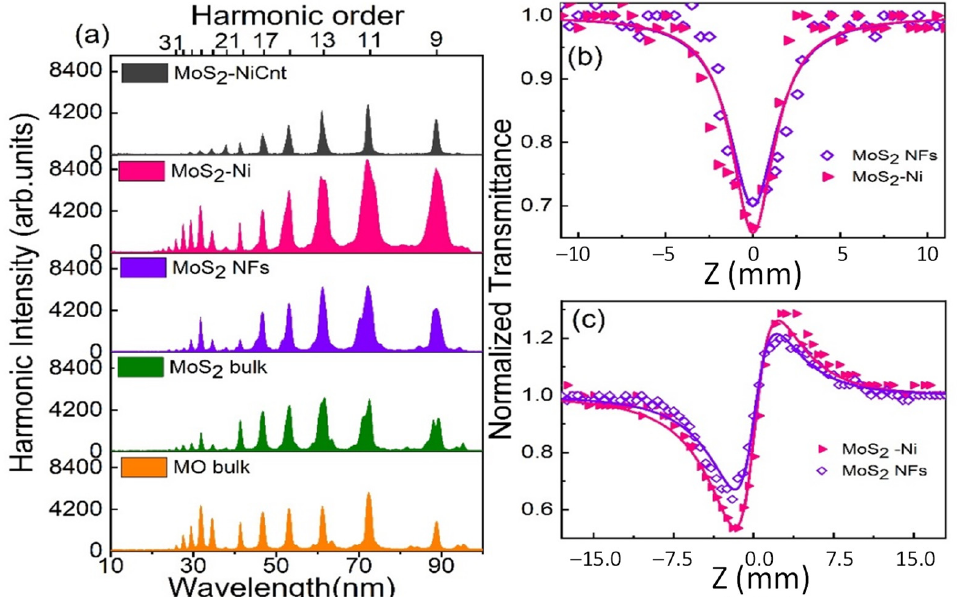
Figure 1. ( a ) Harmonic spectra from picosecond laser-induced plasmas of Mo-related materials. ( b , c ) Z-scans of MoS 2 NFs and MoS 2 -Ni suspensions. ( b ) Open-aperture measurements. ( c ) Closed-aperture measurements. Solid curves in ( b , c ) show the corresponding theoretical fits.